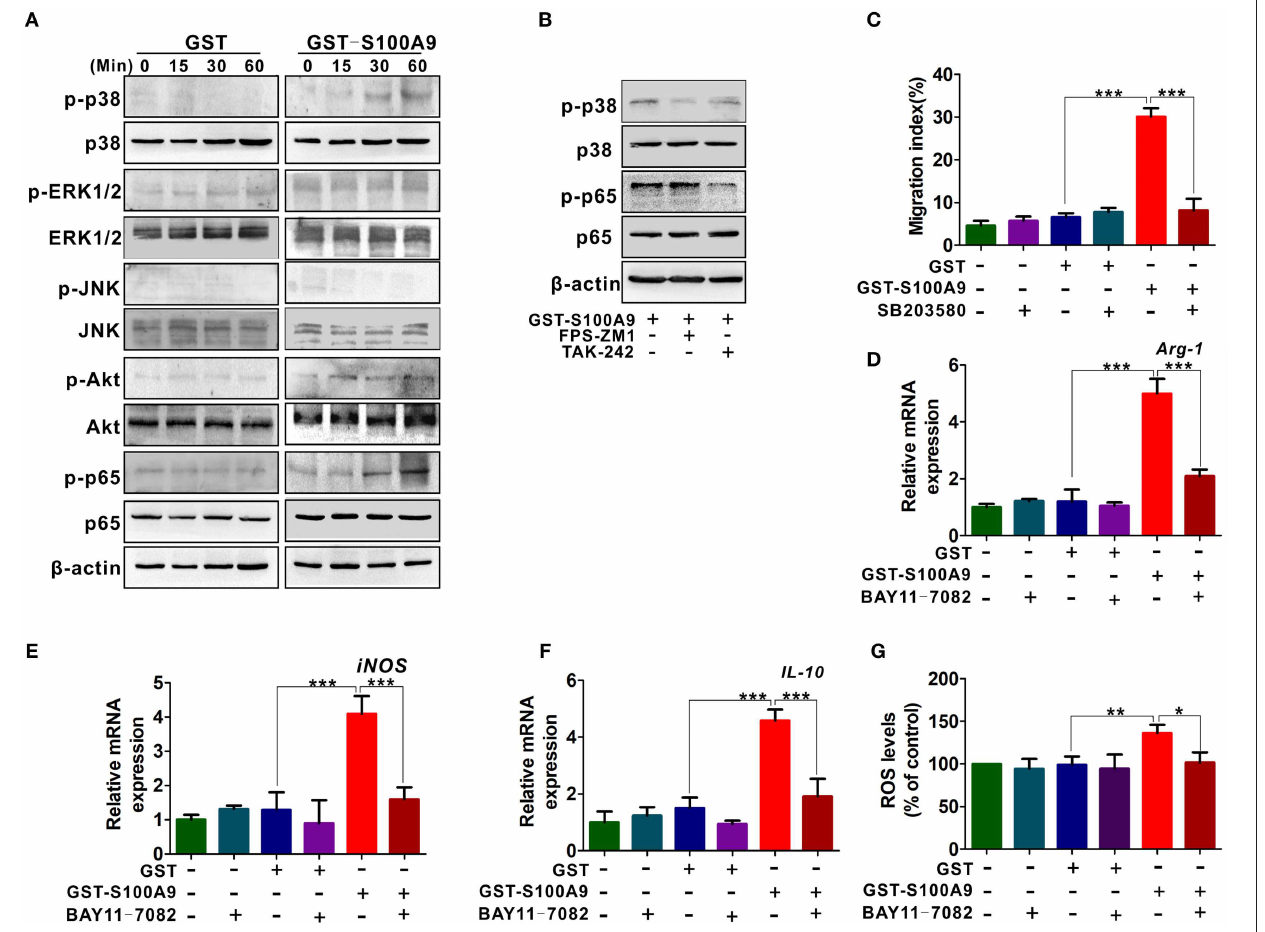
FIGURE 6 | RAGE-mediated p38/MAPK and TLR4-mediated NF- κ B are responsible for the chemotaxis and activation of MDSCs resulted by S100A9. (A) Western blot analysis of p-p38, p-ERK, p-JNK, p-AKT, and p-p65 expression in LoVo-induced MDSCs treated by GST-S100A9 (20 µ g/ml) or GST (20 µ g/ml) for 0, 15, 30, and 60min. (B) Western blot analysis of p-p38 and p-p65 expression in GST-S100A9-treated MDSCs with inhibitors FPS-ZM1 (100nM) and TAK-242 (100nM) for 60min. (C) Chemotaxis assay for LoVo-induced MDSCs pretreated with and without inhibitor SB203580 (50nM) for 30min followed by stimulation with GST-S100A9 (20 µ g/ml) and GST (20 µ g/ml) proteins for 24h. (D–F) Real-time PCR analysis for mRNA expression of immunosuppressive molecules Arg-1 (D) , iNOS (E) , and IL-10 (F) in LoVo-induced MDSCs pretreated with and without inhibitor BAY11-7082 (50nM) for 30min followed by stimulation with GST-S100A9 (20 µ g/ml) and GST (20 µ g/ml) proteins for 24h. (G) Fluorescence intensity analysis for ROS production in LoVo-induced MDSCs pretreated with and without inhibitor BAY11-7082 (50nM) for 30min followed by stimulation with GST-S100A9 (20 µ g/ml) and GST (20 µ g/ml) proteins for 24h. Data represent three independent experiments and are represented as Mean ± SD. * p < 0.05, ** p < 0.01, *** p <